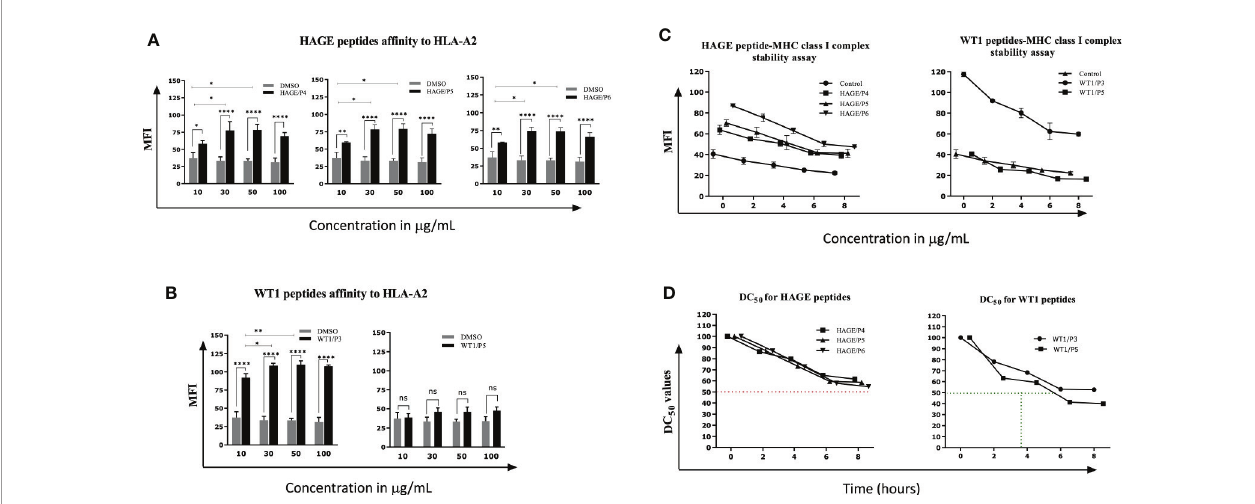
FIGURE 1 | In vitro determination of the HAGE and WT1 peptides-HLA-A*0201 molecule af fi nity and stability. The af fi nity of class I HAGE peptides (HAGE/P4, HAGE/P5 and HAGE/P6) shown in (A) and WT1 peptides (WT1/P3 and WT/P5) shown in (B) to bind HLA-A2 molecules in comparison to controls (DMSO-treated cells) was determined using the T2 binding assay. T2 cells were incubated with 10, 30, 50 and 100µg/mL peptide in serum-free media containing 3µg/mL human b 2m overnight in a 26°C incubator. Cells were stained with an anti-HLA-A2 antibody and propidium iodide (PI), and then immediately analysed using a fl ow cytometer. Values are expressed as the mean ± SD of three independent experiments and the level of signi fi cance was determined using Two Way ANOVA, followed by Tukey ’ s multiple comparisons test. Results indicate that all peptides were strong binders to MHC class I with the exception of WT1/P5. The binding stability (measured by MFI) of class I HAGE peptides and WT1 peptides shown in (C) in comparison to cells that were incubated with the same concentration of DMSO. DC 50 for these peptides is shown in (D) . T2 cells in serum-free medium containing human b 2m at 3µg/mL were incubated with 50µg/mL of the respective peptides overnight and assessed in a time course analysis for HLA-A2 expression using a fl ow cytometer. Values are expressed as the mean ± SD of two independent experiments. All peptide-HLA complexes studied are stable on the T2 cells surface as their DC 50 values were > 8 hours, apart from the WT1/P5- HLA-A2 complex which shows poor stability as there was a drop in DC 50 value earlier between 5-6 hours. *p-value=<0.05, signi fi cant; **p-value=<0.01, very signi fi cant and ****p- value=<0.0001, highly signi fi cant, ns, not signi fi